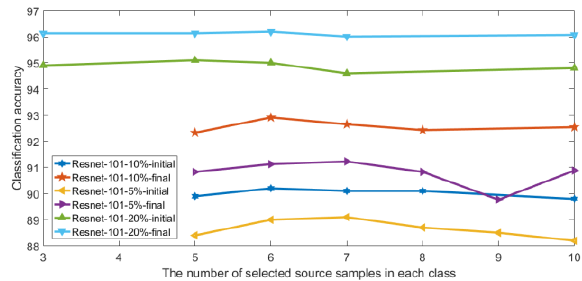
Figure 9. The experimental results of Resnet-101 architecture with diverse chosen source sample number.